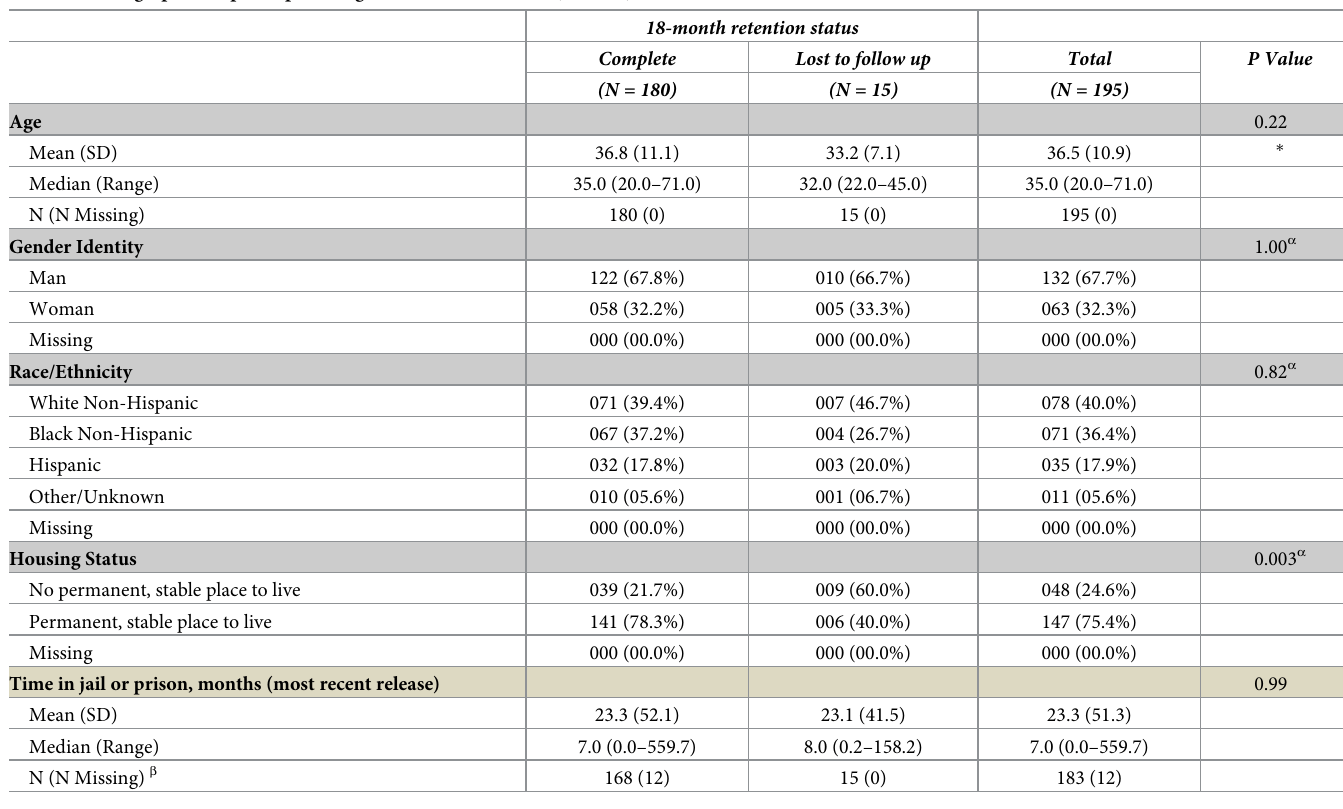
Table 3. Demographics of participants eligible for 18-month visit (N =